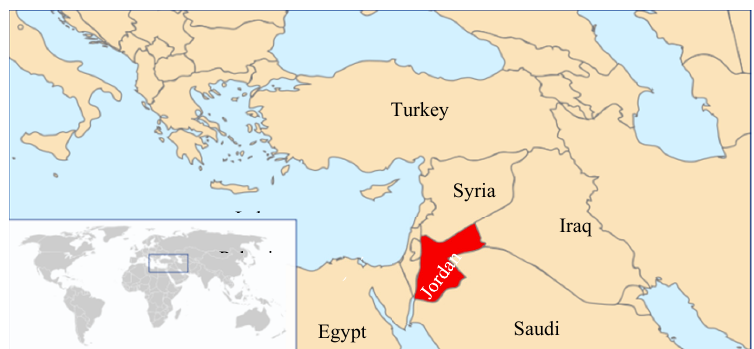
Figure 1. Map of Jordan, location in relation to nearby countries, and the world as in the inset (modified from [5]).